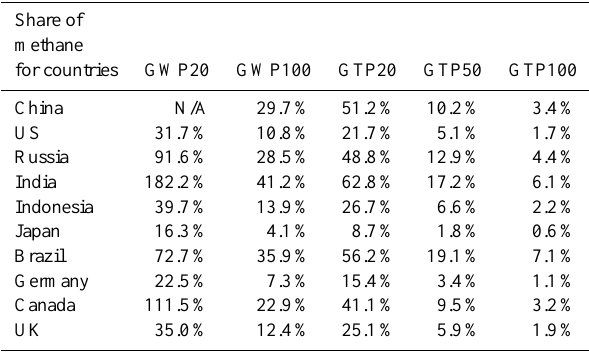
Table 5. The share of methane relative to the total emissions for top ten emitters when using different emission metrics. Due to the strong negative climate response (cooling) of SLCFs in some coun- tries, the shares of CH 4 can be greater than 100% for some metrics with short time horizons. This is not due to CH 4 dominating the to- tal climate impact, but due to cancelation effects between warming and cooling effects (see Fig. 10). For China, there is a net cooling for GWP20; thus, a methane share is not